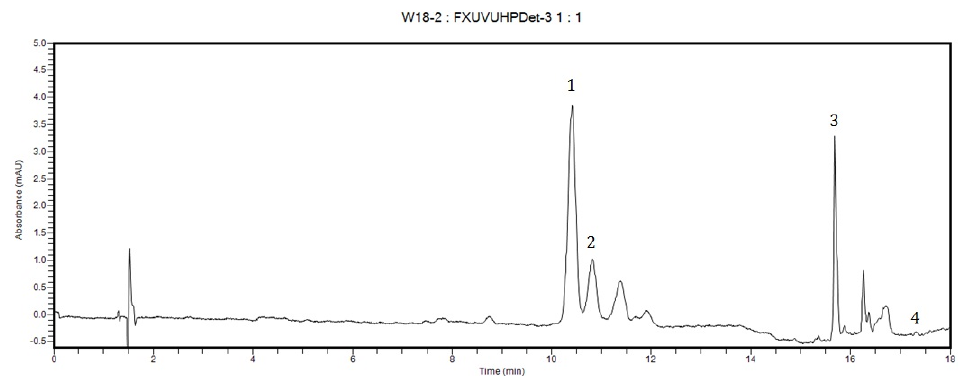
Figure 1. HPLC chromatogram of a representative genotype containing lutein and β -cryptoxanthin as major carotenoids. Peak IDs: 1—lutein, 2—zeaxanthin, 3— β -cryptoxanthin, 4— β -carotene. Table 2. Cytoplasm influence on carotenoid content for a group of isonuclear lines ( µ g/g)—ANOVA test. Total Cytoplasm Lutein Zeaxanthin β -Cryptoxanthin β